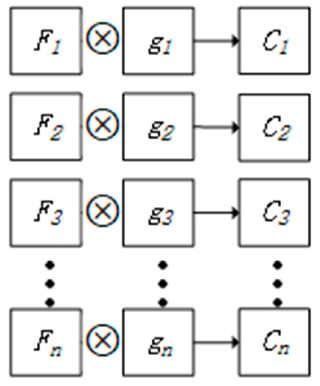
Figure 3. Gabor convolutional layer structure.